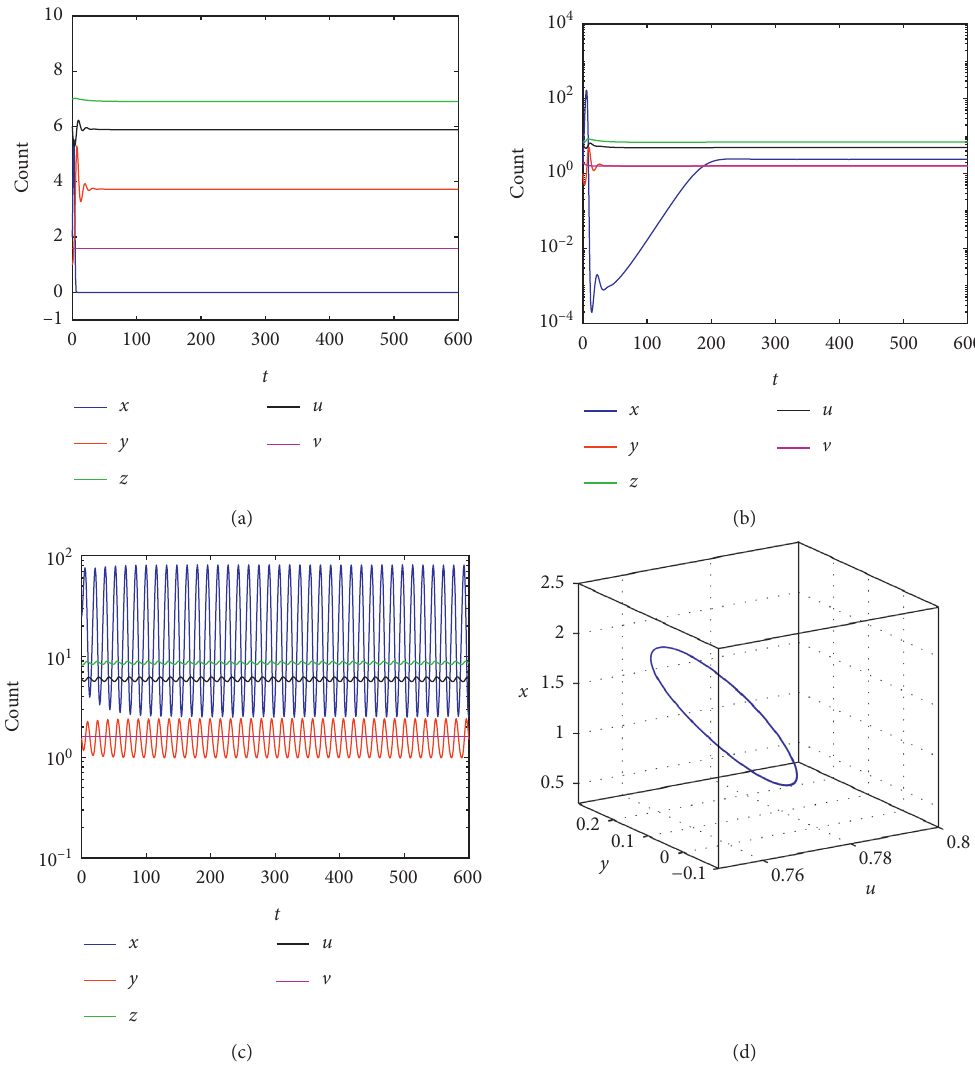
Figure 8: Choose σ � 0 . 4, and the other parameter values are given in (22). (a) When θ � 0 . 5, F 3 (b) When θ � 0 . 6, F ∗ ( 2 . 413 , 1 . 628 , 7 . 032 , 5 . 002 , 1 . 6 ) is LAS. (c) When θ � 0 . 635, F ∗ ( 27 . 345 , 1 . 546 , 8 . 624 , 5 . 93 , 1 . 6 ) is unstable. (d) When θ � 0 . 635, the 3D phase portrait depicts TCs, ECs, and